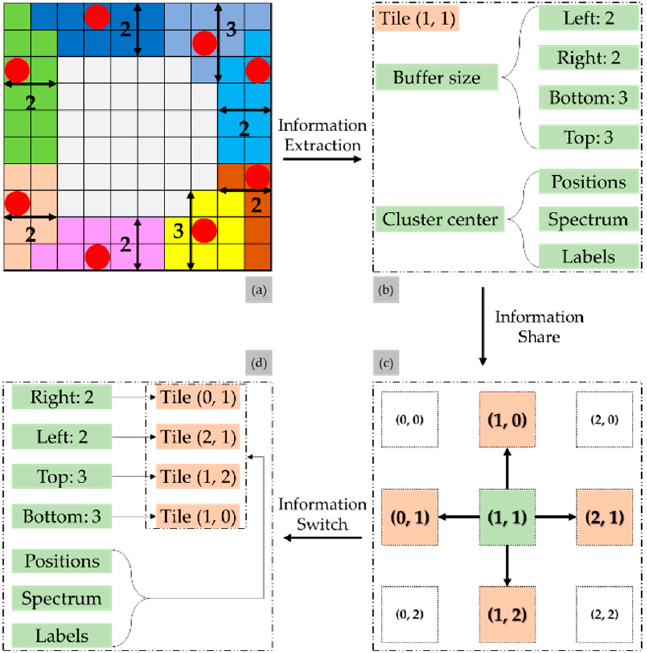
Figure 3. The extraction and switching of buffer sizes and cluster centers. ( a ) Segmented Even tile; ( b ) Extracted information; ( c ) Broadcasted information; ( d ) Switched information.